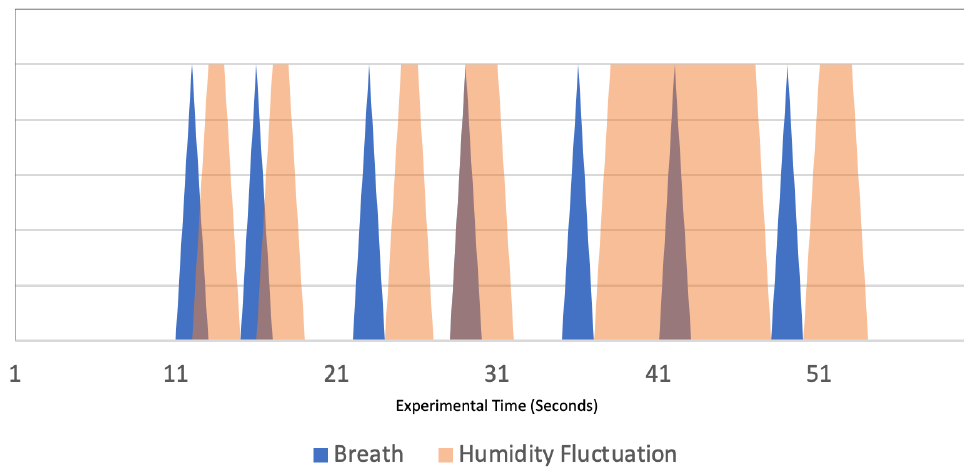
Figure 12. Breathing Patterns and Humidity